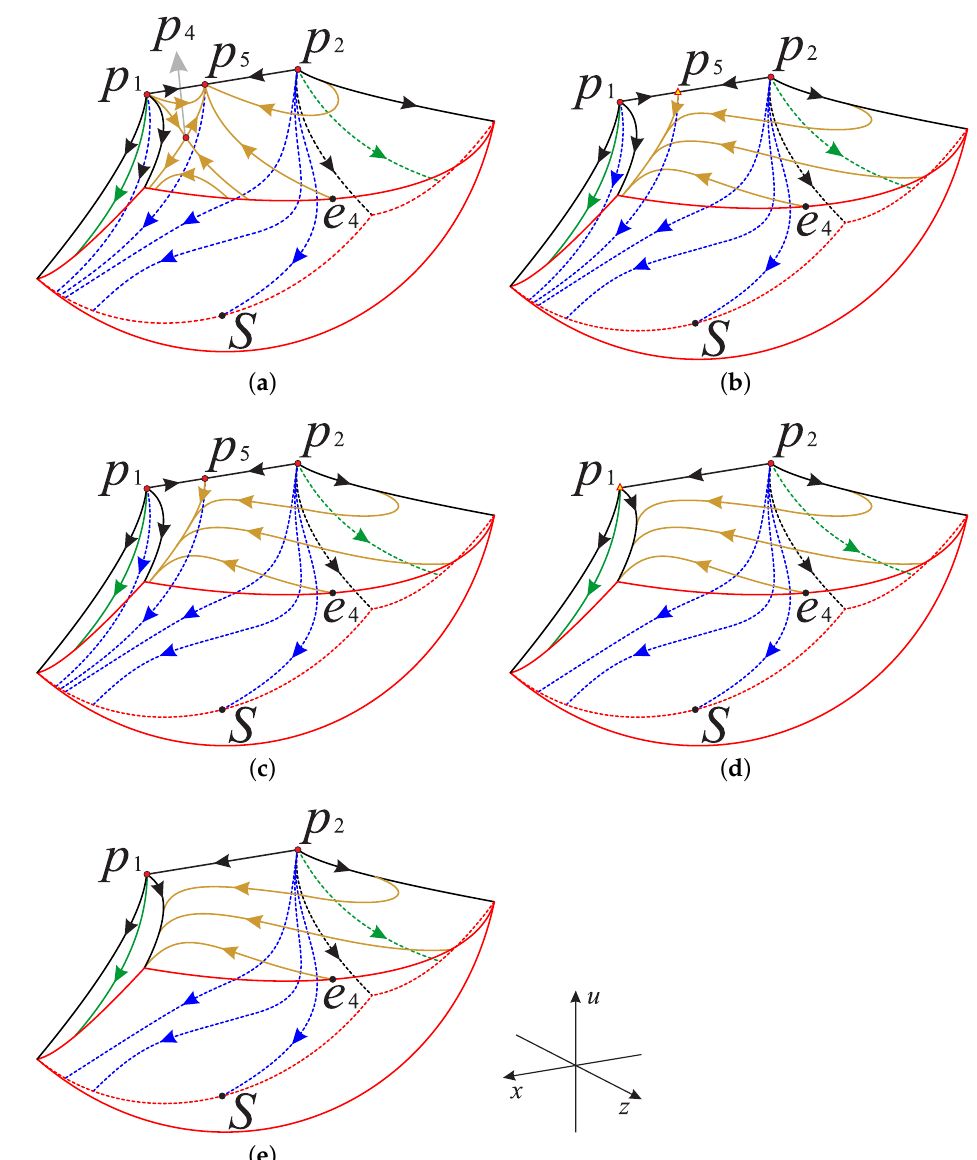
Figure 17. Phase portrait in the boundary of the region R 2 for different values of s : ( a ) 0 < s < 1, √ √ √ ( b ) s = 1, ( c ) 1 < s < 6/2, ( d ) s = 6/2, ( e ) s > 6/2. The surfaces above and below the long dashed line represent regions I and III,